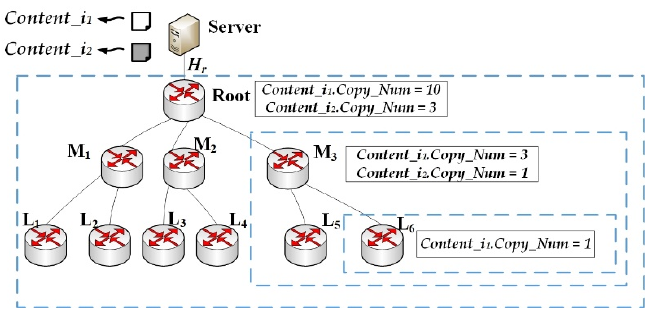
Figure 4. An example of the Expected Number of Copies (ENC)-based caching scheme.